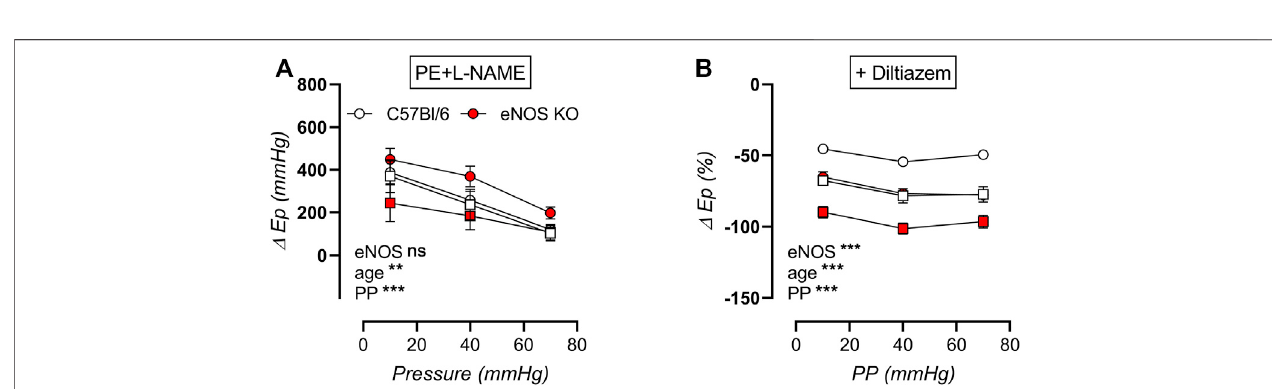
FIGURE 14 | Stretch dependency of contraction-dependent aortic stiffening. Aortic rings of young (4 months, n = 6) and aged (13 months, n = 4) eNOS knockout and young (4 months, n = 6) and aged (14 months, n = 4) C57Bl/6 control mice were subsequently exposed to 5 min of cyclic stretch at low (10 mmHg), physiological (40 mmHg),andhigh(70 mmHg)pulsepressure(PP).Contraction-dependentaorticstiffeningby2 μ MPEwasplotted (A) ,andtherelativeinhibitionof2 µMPE-induced aortic stiffening by addition of 35 µM diltiazem was assessed as measure of VGCC contribution (B) . Statistical analysis was preformed using three-way ANOVA. Only the overall signi fi cance (bottom) is listed. ns, p > 0.05, **, p < 0.01; ***, p < 0.001.